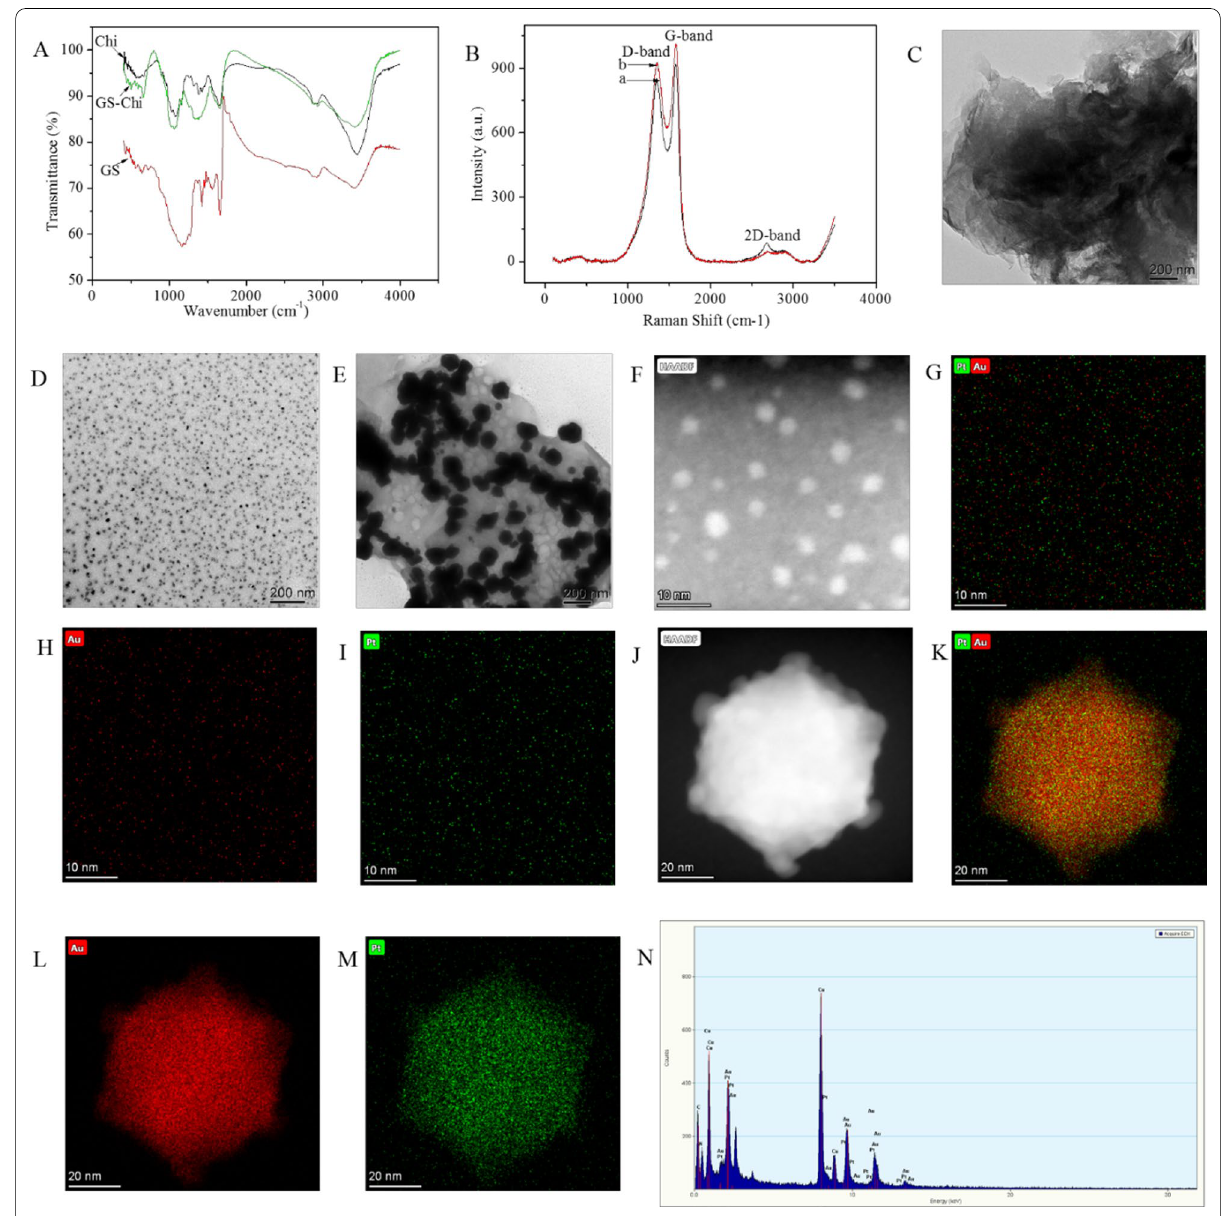
Fig. 2 Characterization of the related nanocomposites. A FT-IR spectra of Chi, GS, and GS-Chi. B Raman spectra of GS (a) and GS-Chi (b). TEM images of GS-Chi ( C ), Chi-Au/Pt ( D ), and GS-Chi-Au/Pt ( E ). HRTEM image of Chi-Au/Pt ( F ). Overlay on the image of Chi-Au/Pt ( G ). Au elemental mapping image of Chi-Au/Pt ( H ). Pt elemental mapping image of Chi-Au/Pt ( I ). HRTEM image of GS-Chi-Au/Pt ( J ). Overlay on an image of GS-Chi-Au/Pt ( K ). Au elemental mapping image of GS-Chi-Au/Pt ( L ). Pt elemental mapping image of GS-Chi-Au/Pt ( M ). EDS elemental analysis of GS-Chi-Au/Pt ( N